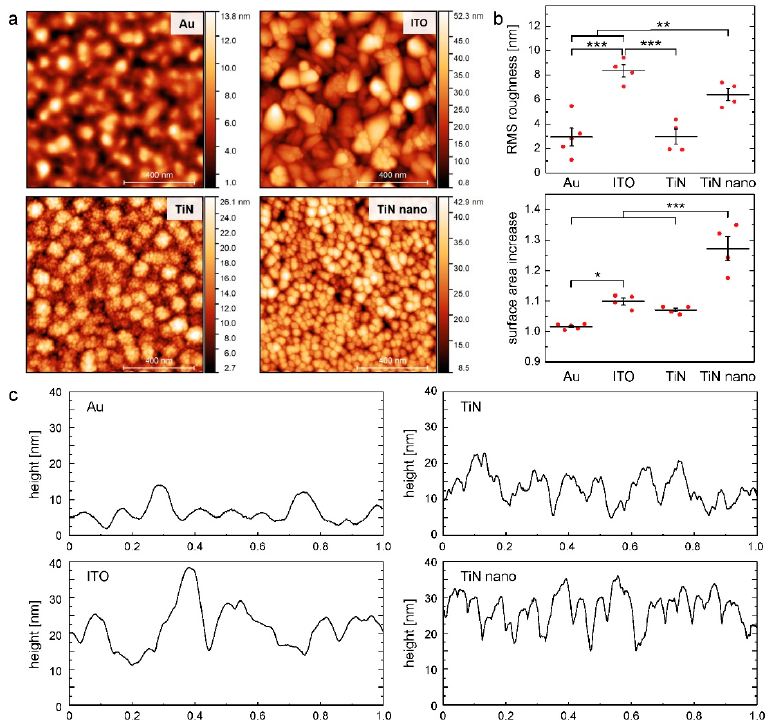
Figure 1. Atomic force microscopy characterization of the tested electrode materials: ( a ) 1 × 1 µm images of gold (Au), indium tin oxide (ITO), titanium nitride (TiN), and TiN nano with nanocolumnar structure; ( b ) area-derived metrics of the AFM images (root-mean-square (RMS) roughness and ratio of surface area to projected area (surface area increase)); the horizontal lines represent the mean values of the data points (red dots), while the vertical lines show the standard errors (mean ± se, ANOVA with Tukey’s post-hoc test, * = p < 0.05, ** = p < 0.01, *** = p < 0.001); ( c ) one-line profiles of AFM images.